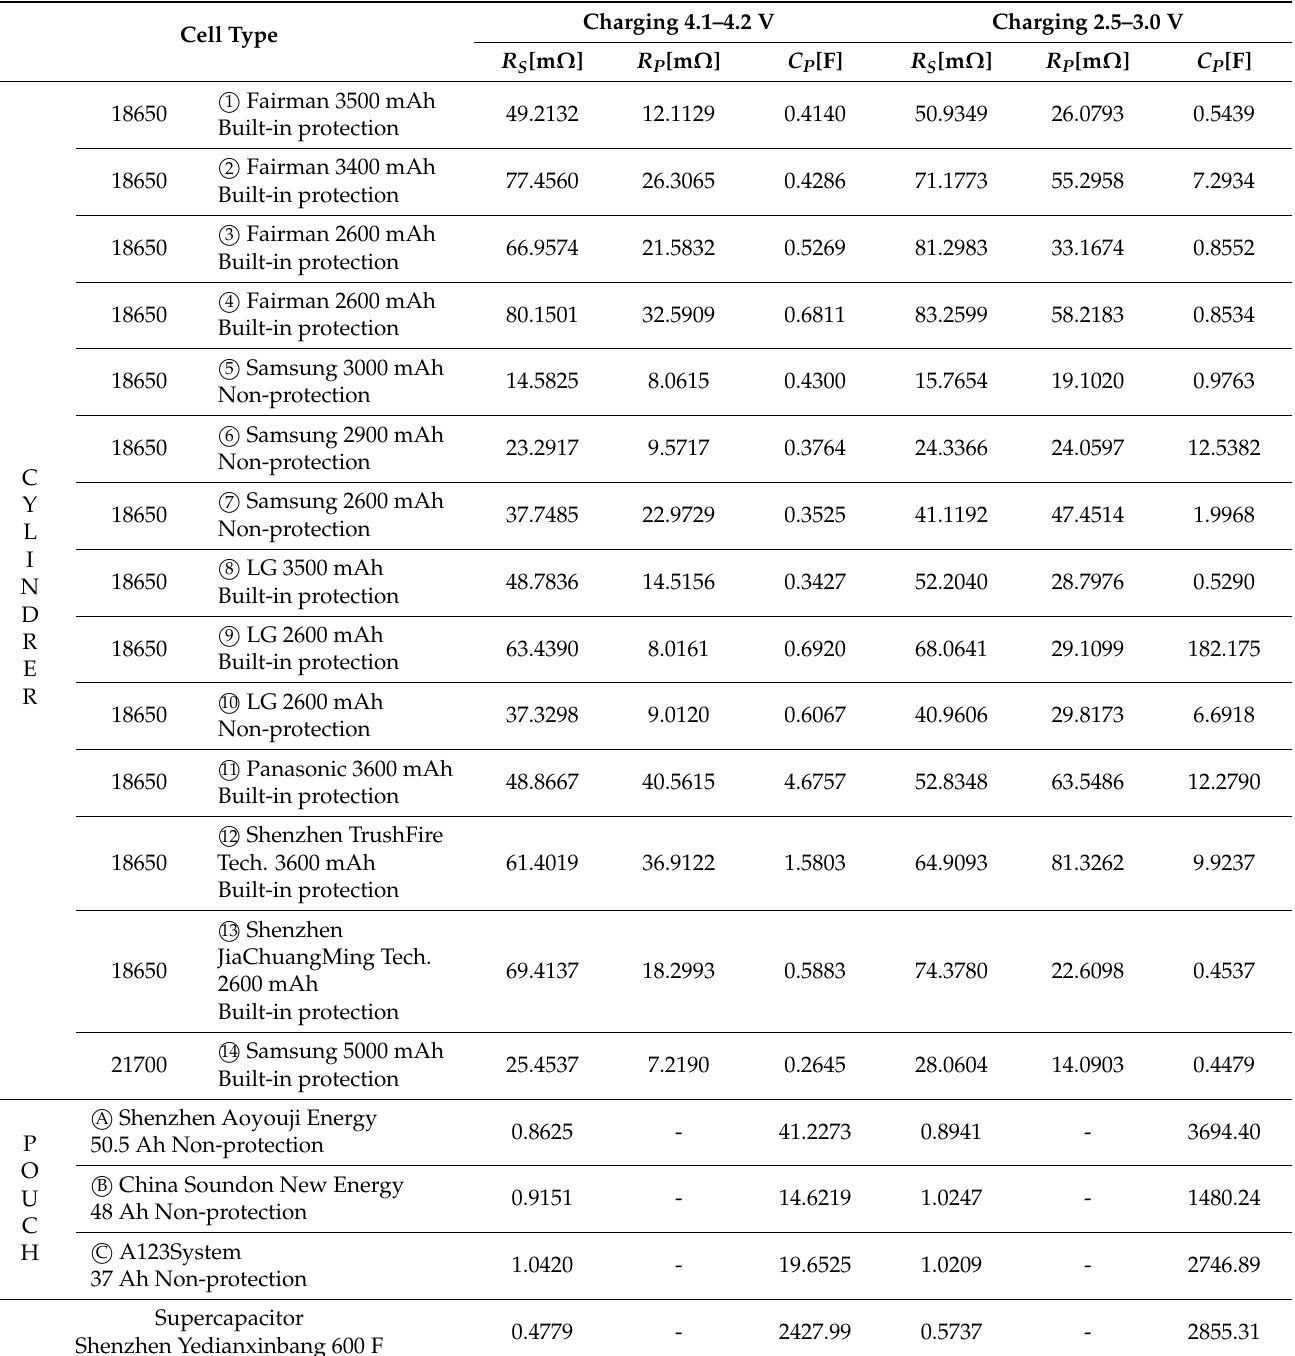
Table 2. R S , R P , and C P values of Li-ion batteries and